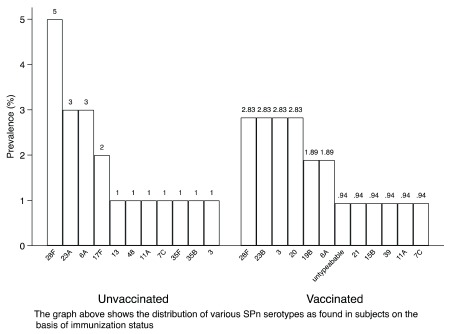

S. pneumoniae Serotype Distribution by PCV-10 Vaccination Status.